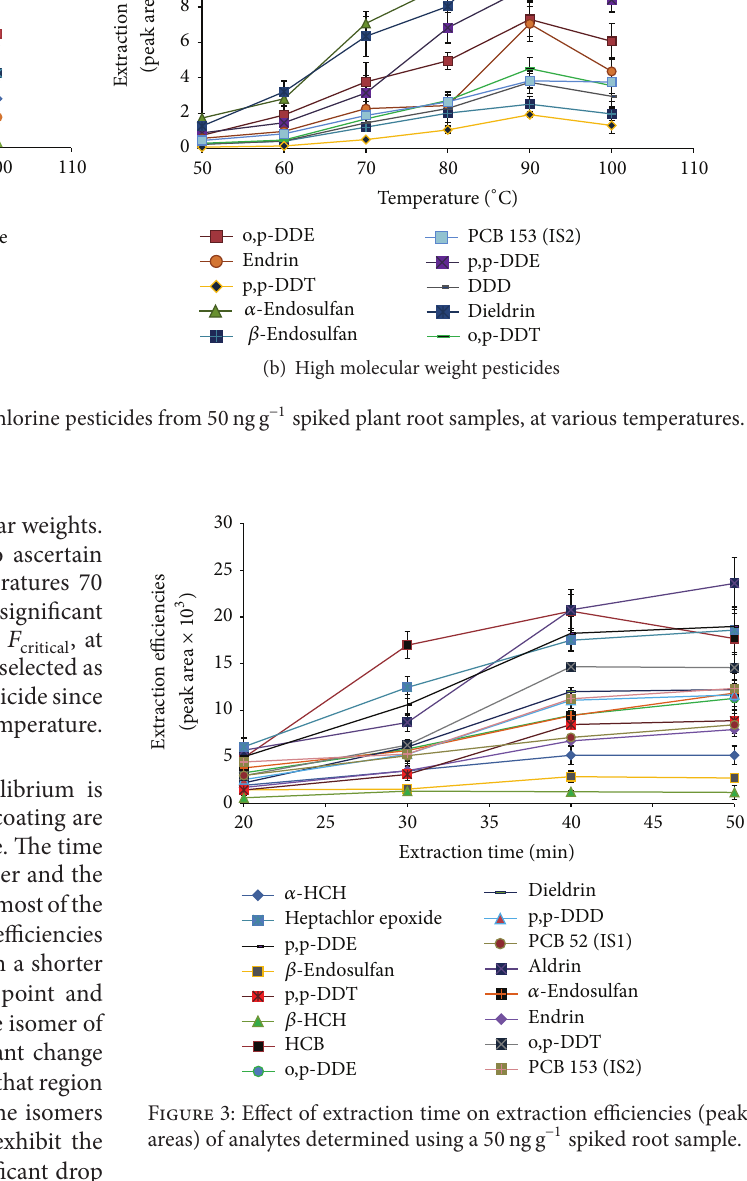
Figure 3: Effect of extraction time on extraction efficiencies (peak areas) of analytes determined using a 50 ng g −1 spiked root